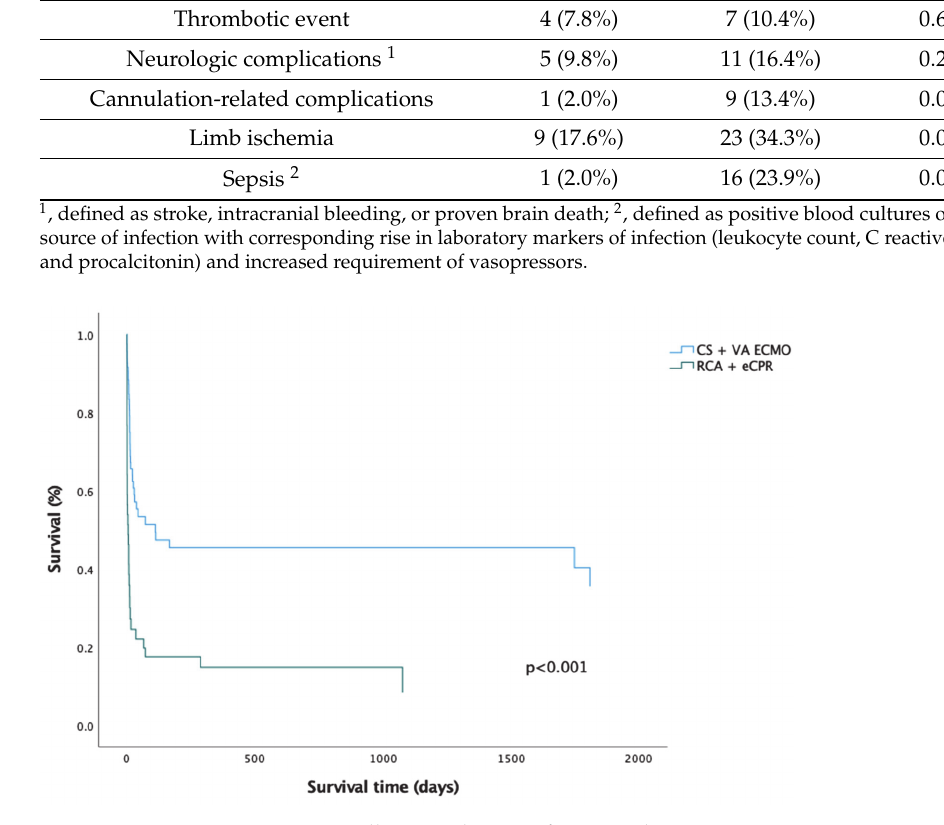
Figure A1. Cox Regression overall survival curves for CS and RCA patients. Table A3. Cox Regression covariates analysis overall survival.